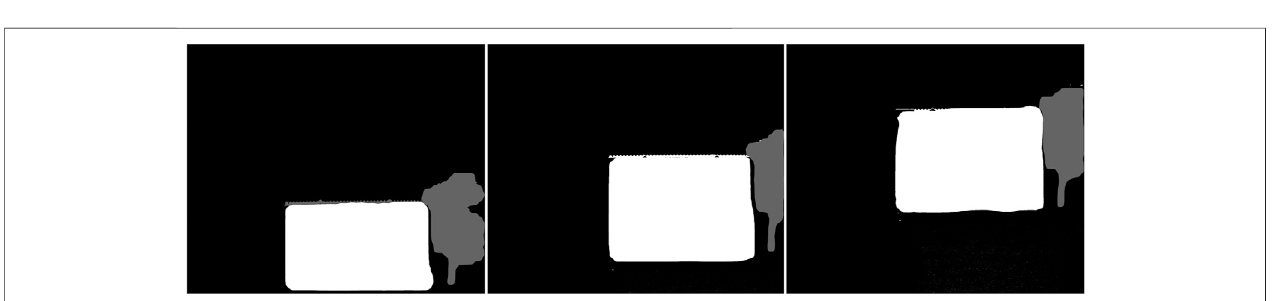
FIGURE 7 | Three gray images with